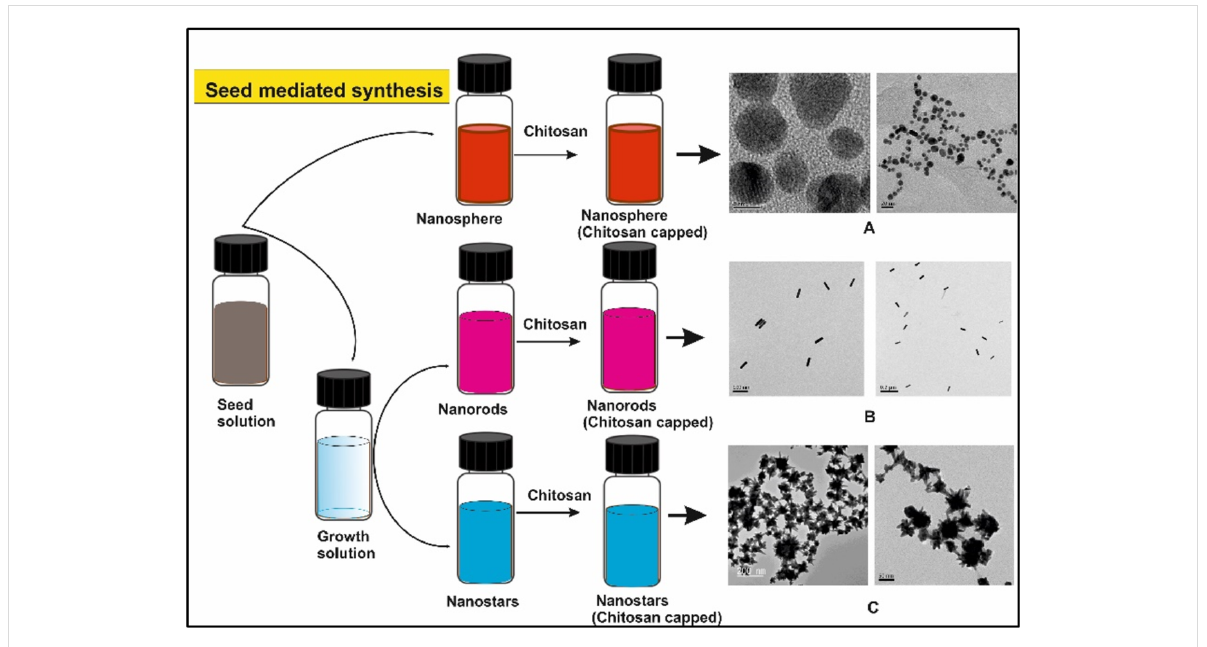
Figure 3: Synthesis of gold nanoparticles of different shapes using the seed-mediated approach. Chitosan was used for post functionalization of (A) gold nanospheres, (B) nanorods and (C) nanostars. Adapted from [54], © 2019 Y. J. Lee et al., distributed under the terms of the Creative Commons Attribution 4.0 International Licence,